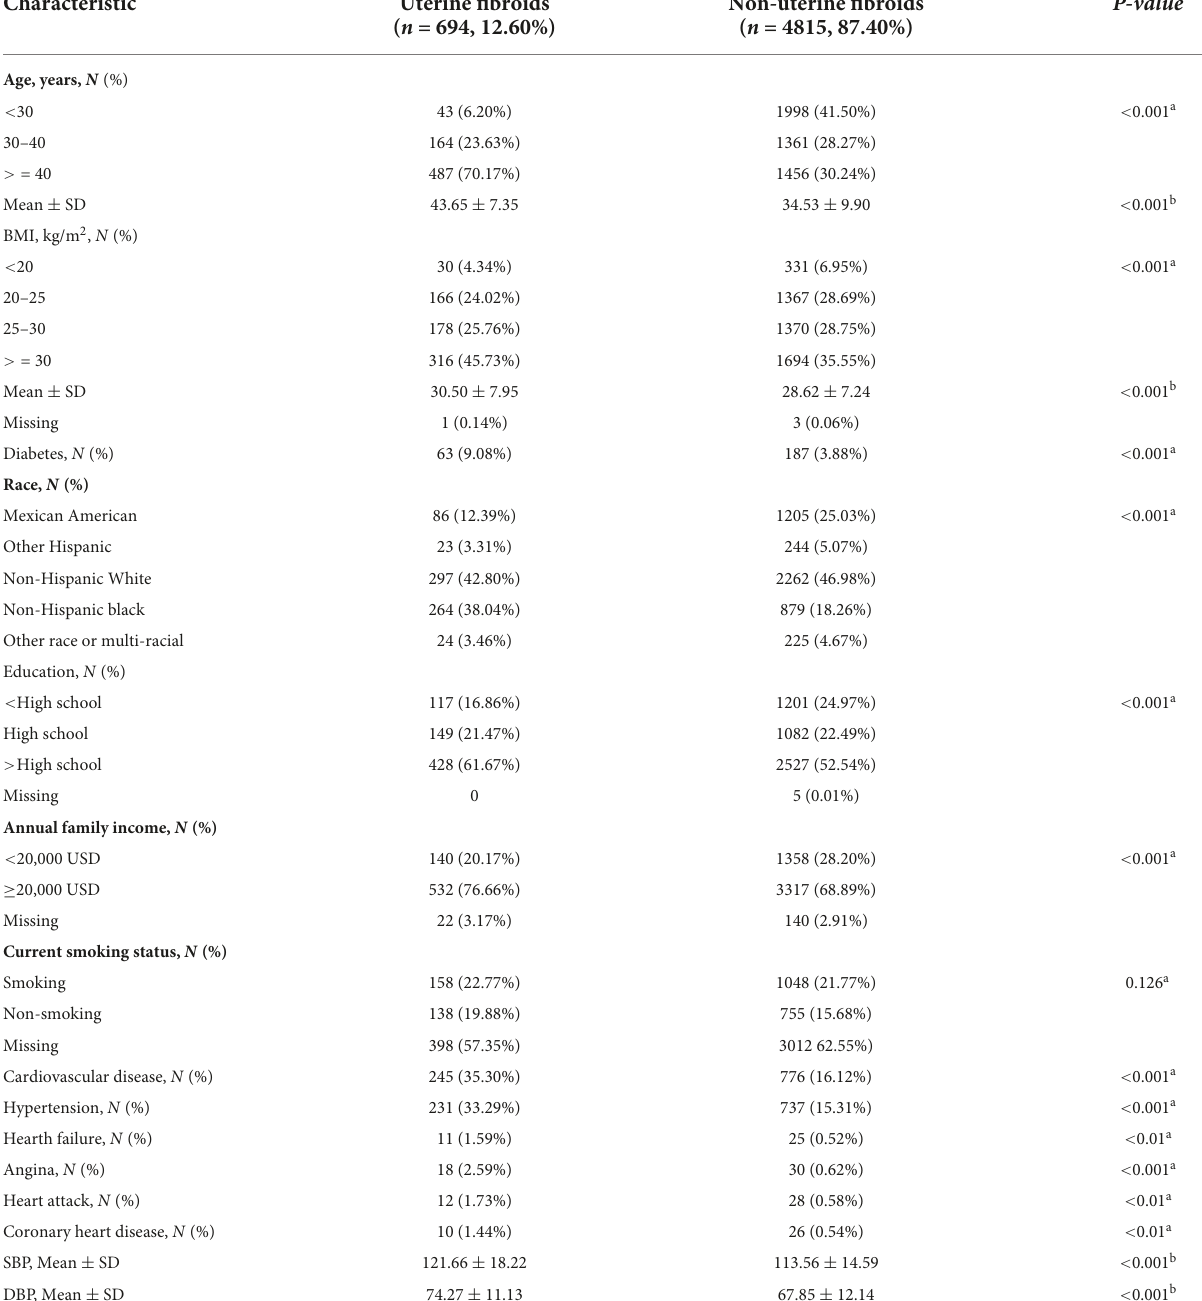
TABLE 1 Demographics and clinical characteristics of participants [National Health and Nutrition Examination Survey (NHANES) 1999–2006]. Characteristic Uterine fibroids ( n = 694,